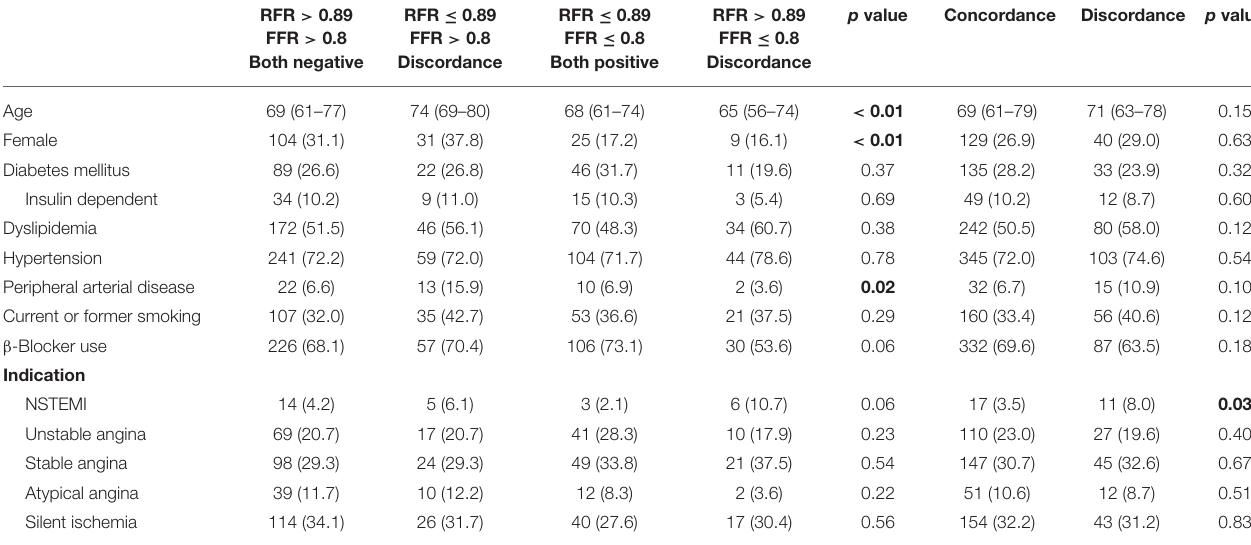
TABLE 3A | Comparison of patient characteristics between concordant and discordant cases of RFR and